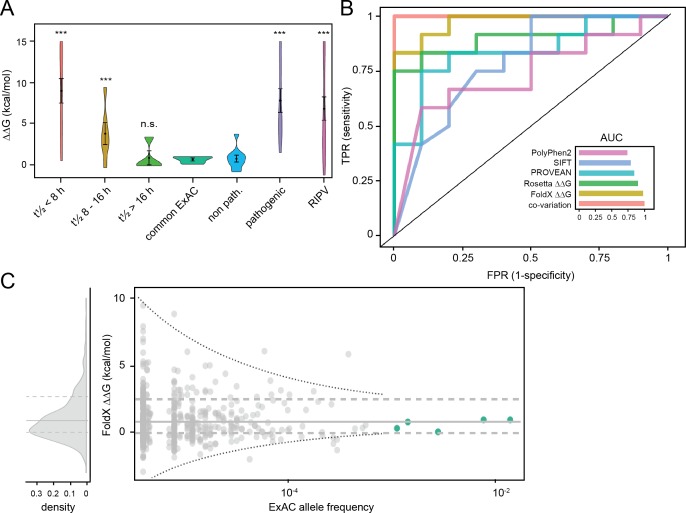
Pathogenicity predictions of MSH2 mutations.(A) Distributions of FoldX ΔΔG scores for MSH2 variants tested in this work with short (red), intermediate (yellow), and long (light green) half-life (t½), common variants found in ExAC (dark green), known non-pathogenic (blue) and pathogenic (purple) variants, and recently identified pathogenic variants (RIPV, magenta) [30]. Dots indicate the mean ΔΔG score for each group, and the bars indicate the standard error of the mean. (B) Receiver operating characteristics (ROC) curves for the selected predictors of MSH2 variant pathogenicity: co-variation (red), FoldX ΔΔG (yellow), Rosetta ΔΔG (green), PROVEAN (cyan), SIFT (blue), and PolyPhen2 (purple). Accuracy is assessed on known pathogenic and non-pathogenic variants according to Houlleberghs et al., 2016. As the area under the curve (AUC) indicates, while all predictors show reasonable performance, ΔΔG and co-variation provide considerably higher accuracy. (C) The distribution of FoldX ΔΔG scores vs. the allele frequency of MSH2 mutations found in the Exome Aggregation Consortium (ExAC) database. Note that alleles that are found at a high frequency in the population, and are therefore unlikely to be pathogenic, appear stable (display low ΔΔG values). The three horizontal lines correspond to quartiles. For further information, refer to S6 Fig.